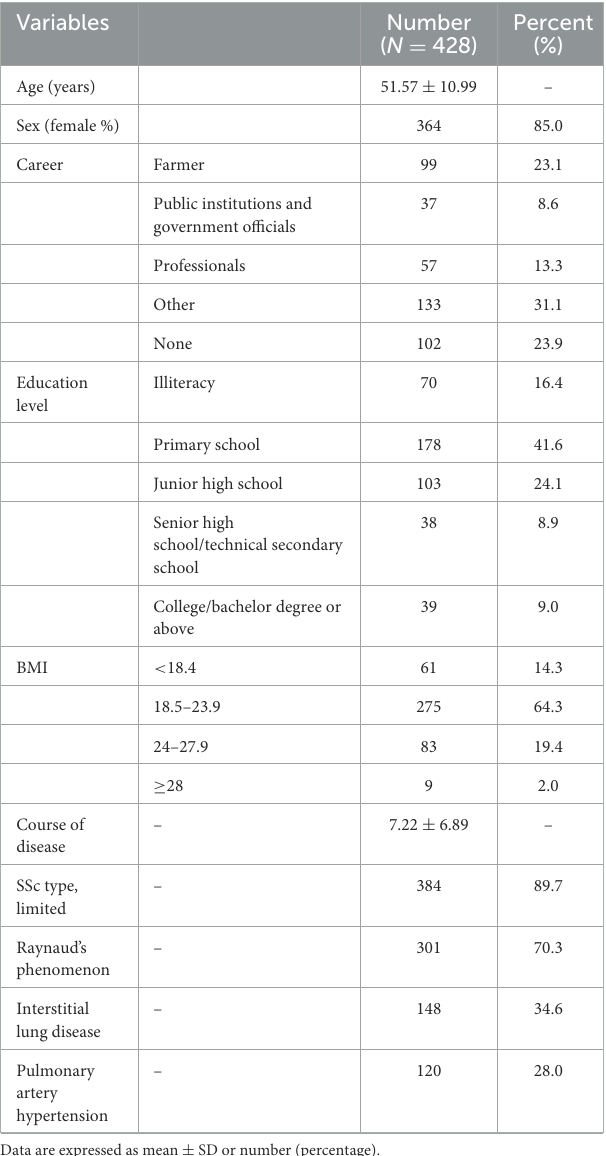
TABLE 1 General demographic characteristics of SSc